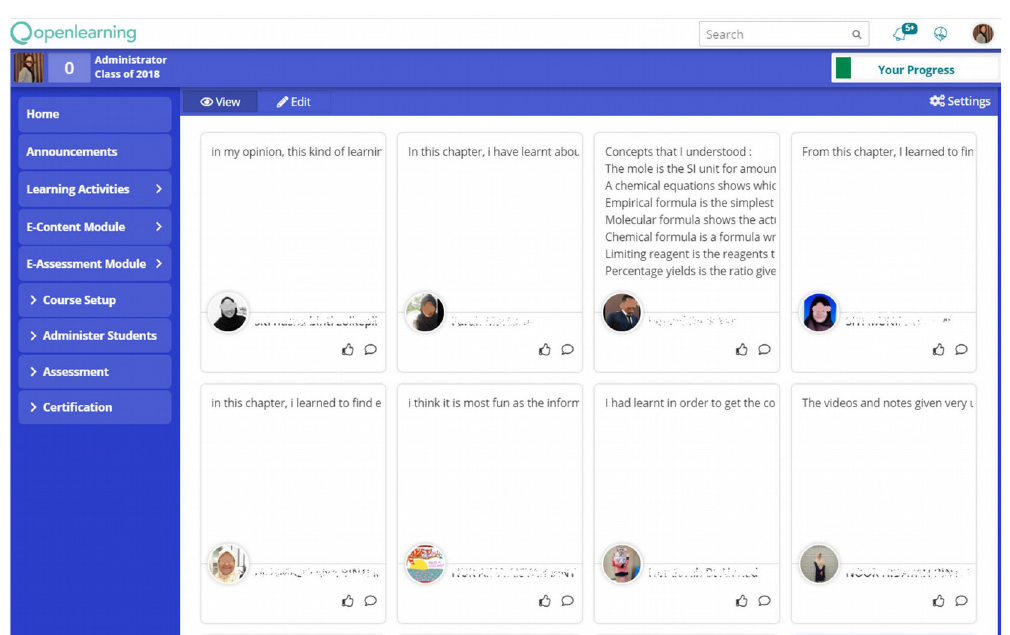
Figure 15. Students share their